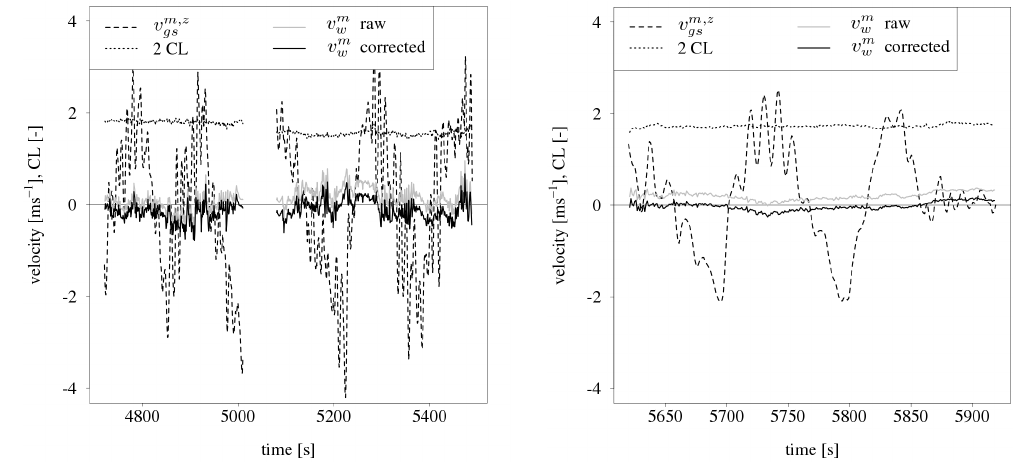
Fig. 10. Smooth oscillation flights (VW2) on 24 June 2008 (left) and 25 June 2008 (right). In addition to the variables explained in Fig. 8 the vertical aircraft velocity ( v m ,z gs ) is shown. Additional information is given in Sect. 4.1 Step G3. using the VW1 flight on 25 June 2008 during ambiguous cy- clonality atop and below measurement altitude (Table 3). In Fig. 9 the determination of α upw , slo depends on the change